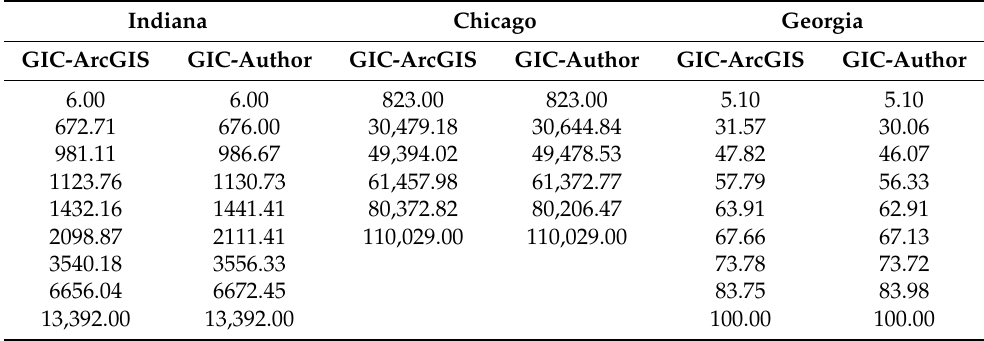
Table 2. Break points of GIC for populations of Indiana, Chicago, and simulated population of Georgia.